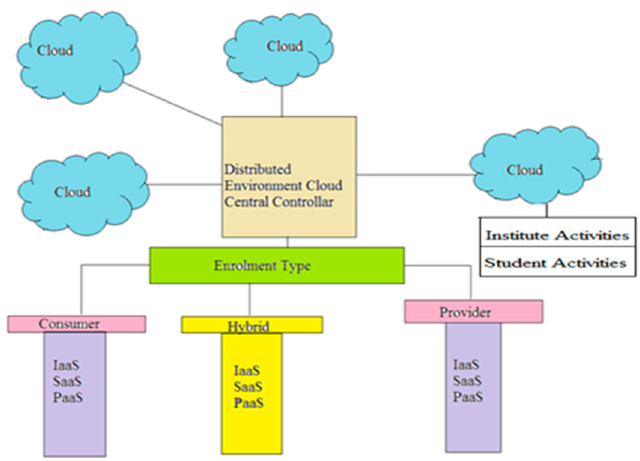
Figure 3. Proposed architecture enterprise resource planning of cloud computing from the perspective of women’s education.